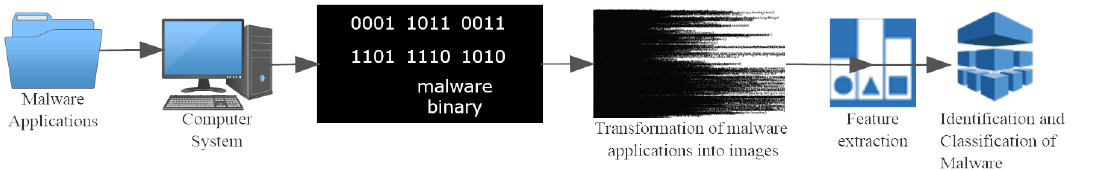
Figure 1. Simplistic depiction of adopted methodology for classification of Android